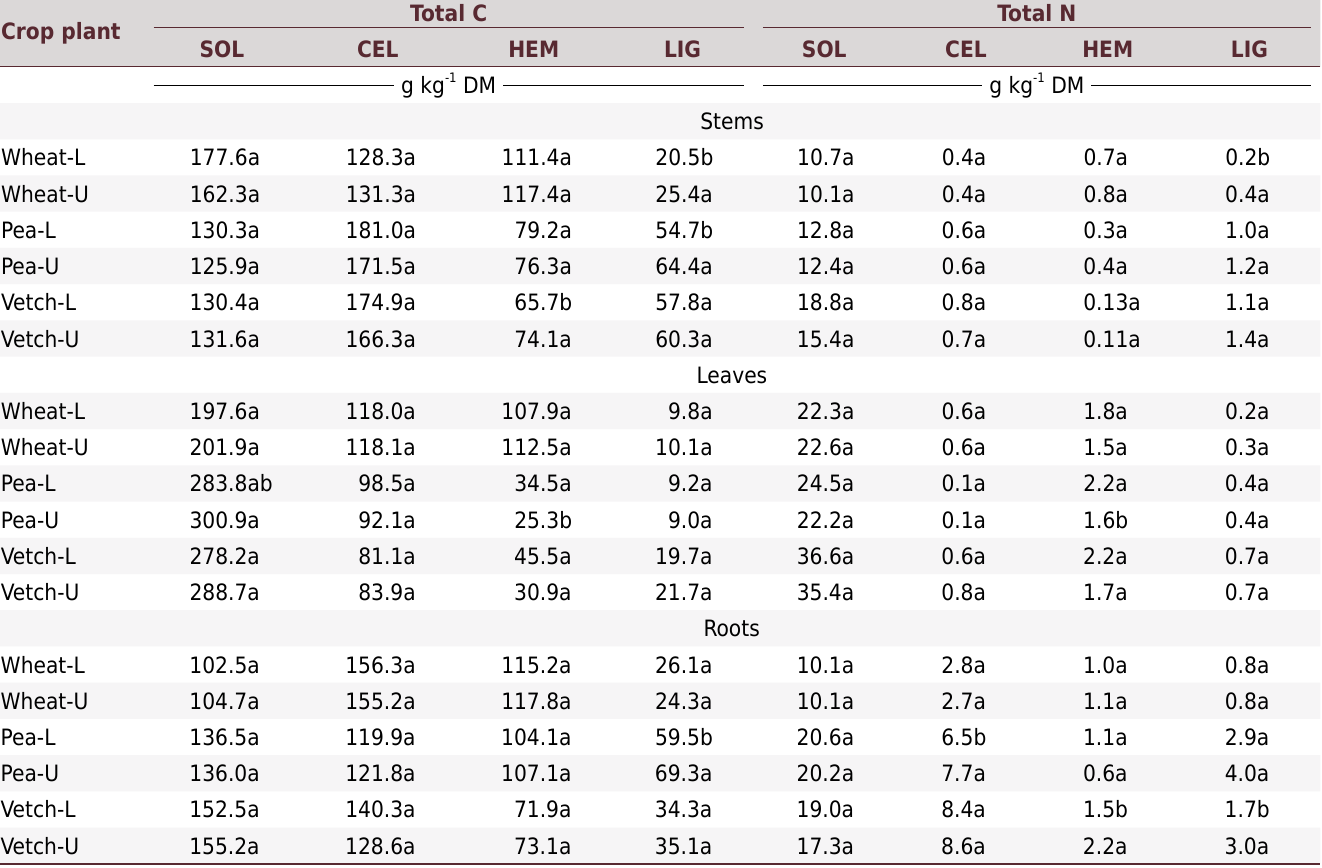
Table 2. Total C and total N contents of chemical fractions from labeled and unlabeled crop plant parts (stems, leaves, and roots) grown under field conditions Crop plant